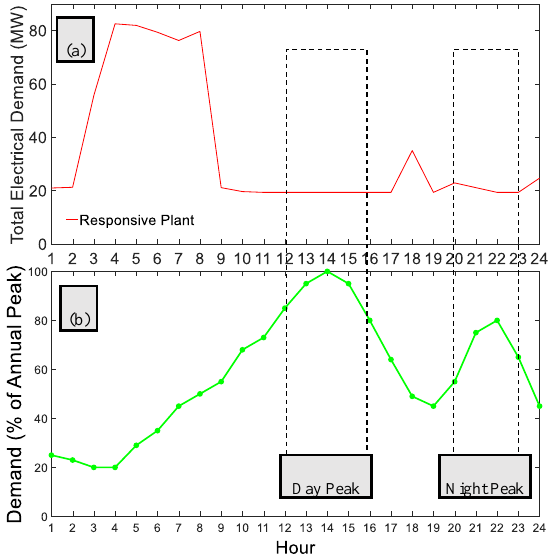
Figure 14. ( a ) Optimized electrical demand of the ORI in response to ( b ) demand profile of Iran Power Grid (IPG).